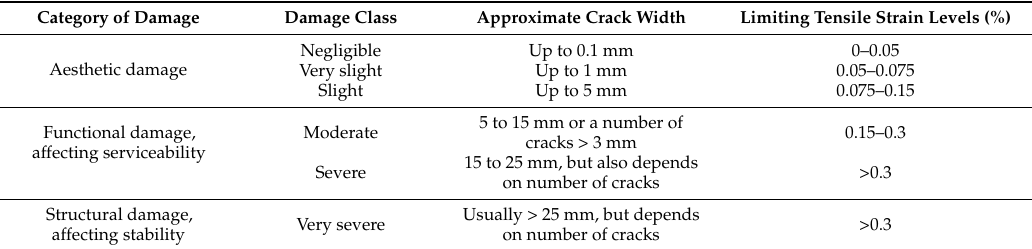
Table 1. Damage classification of building, based on limiting tensile strain levels and expected crack width